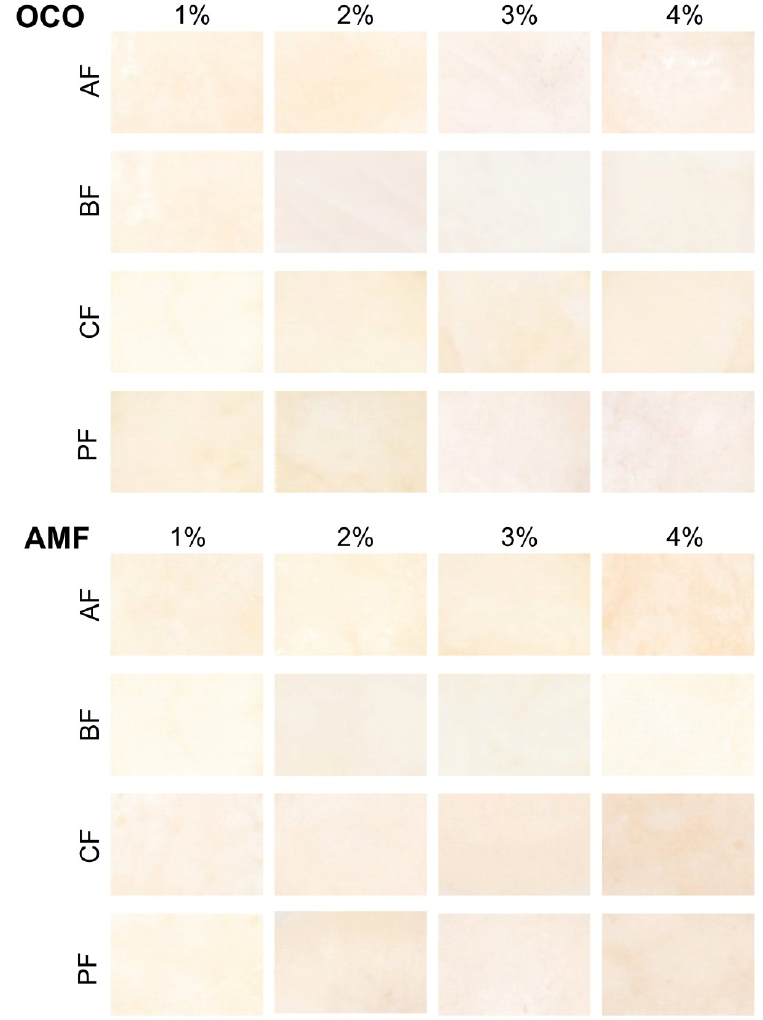
Figure 5. Effect of different fibers concentration of color of acid casein PCS (processed cheese sauces) with WPC80 (whey protein concentrate) and OCO (organic coconut oil) or AMF (anhydrous milk fat) measured with CVS (computer vision system).